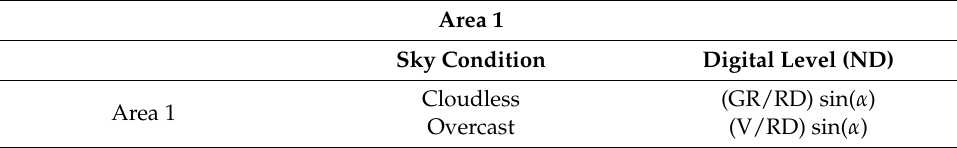
Table 1. Determination of the best correlations of digital image levels based on the solar altitude (ND) and the sky